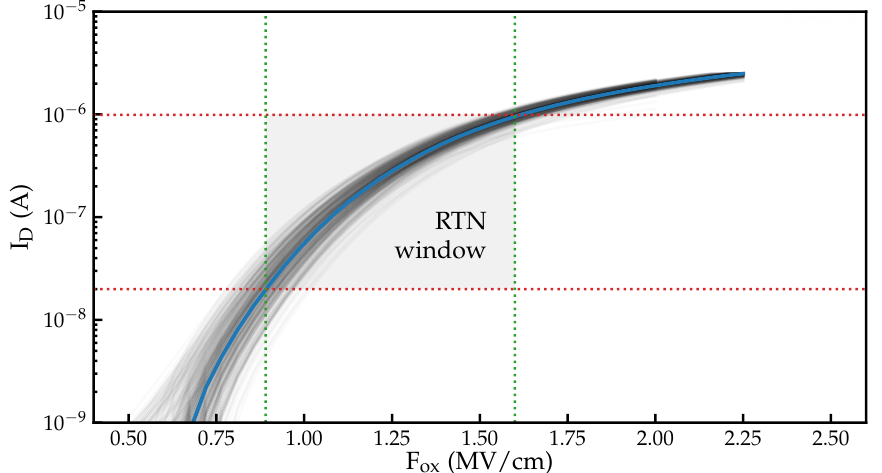
Figure 2. Transfer characteristics measured on approximately 300 nominally identical devices, with the average characteristic indicated in blue. The bias range (green) and current range (red) used for RTN measurements in this work is indicated using dotted lines.